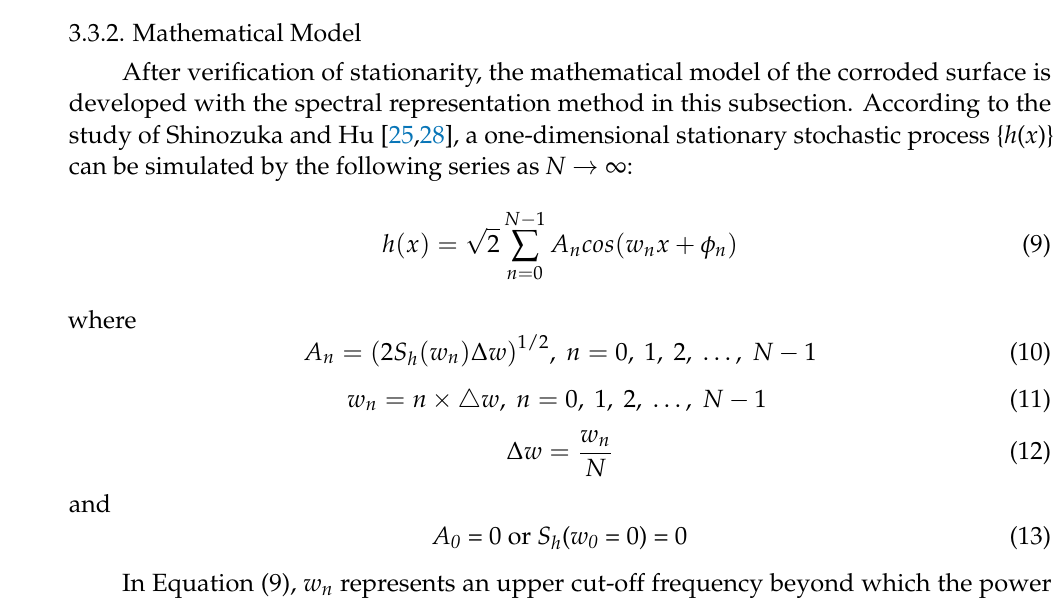
Figure 11. Correlation function of surface height of two-dimensional contour curves.